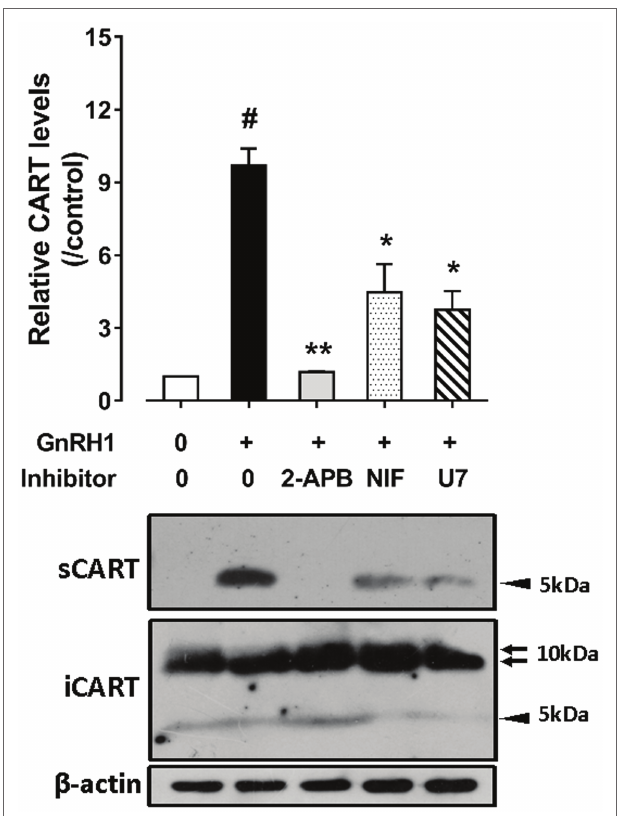
FIGURE 6 | Western blot detected the effect of chicken GnRH1 (5 nM, 4 h) on cocaine- and amphetamine-regulated transcript (CART) secretion in the incubation medium of chick pituitaries incubated in vitro in the presence of 2-APB (100 μM), nifedipine (NIF, 5 μM), or U73122 (U7, 20 μM). The relative CART levels (sCART: ~5 kDa band) in the incubation medium were quantified by densitometry, normalized by that of β -actin band in pituitary tissue lysate, and then expressed as fold increase of controls without any treatment. iCART, intracellular CART, showed three major bands in pituitary tissue lysates. Each data point represents mean ± SEM of three replicates ( N = 3). # p < 0.001 vs. control; * p < 0.05, ** p < 0.01 vs. GnRH1 treatment (in the absence of drug). One representative set of Western blotting is shown at the